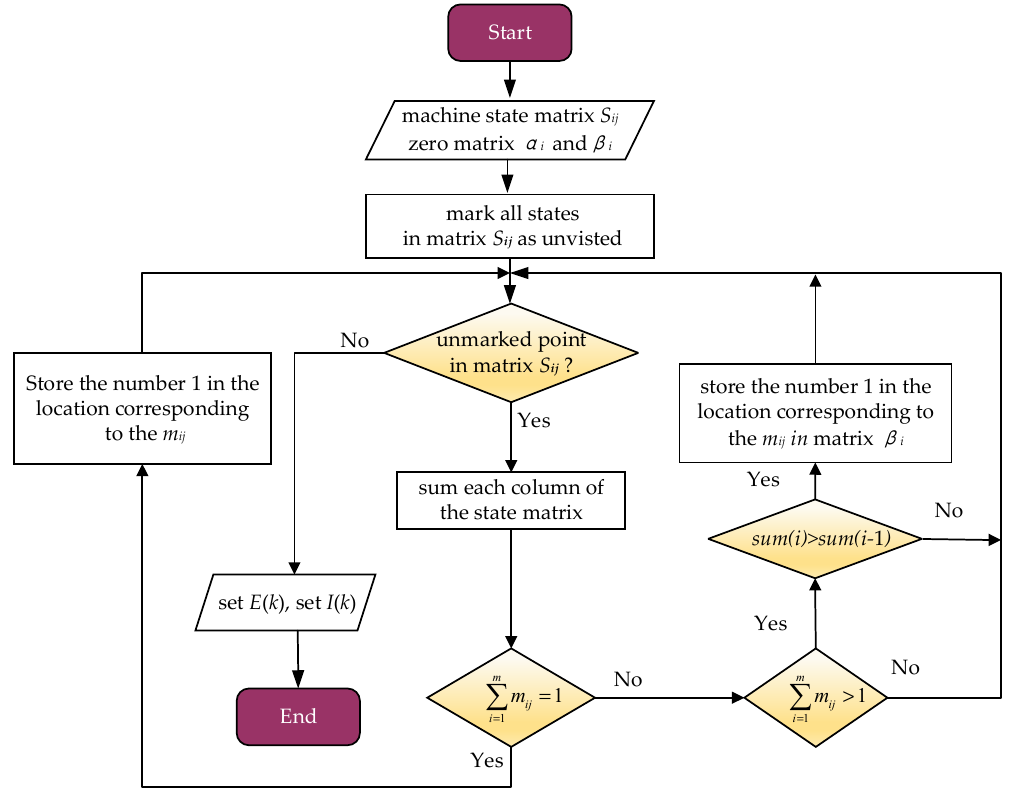
Figure 8. The dynamic bottleneck recognition flowchart.